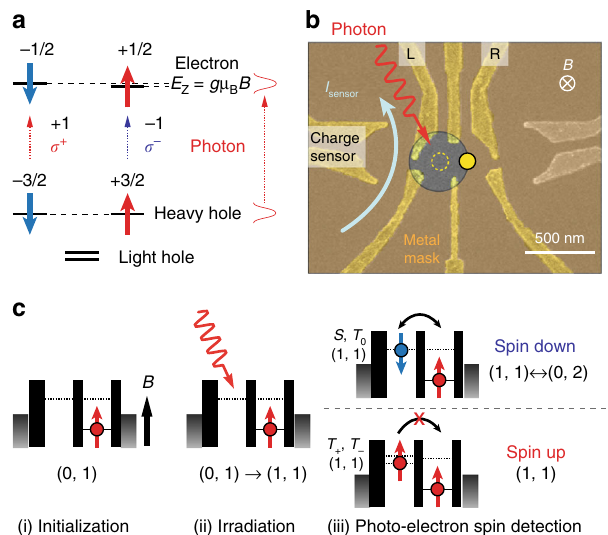
Fig. 1 Photo-electron spin detection scheme. a Angular momentum conservation in the heavy-hole band excitation. The numbers are the angular momenta of the respective particles in units of ħ . b Scanning- electron-micrograph picture of the double quantum dot (DQD) gate pattern nominally identical to the measured sample. We mainly use the charge sensor quantum dot (QD) formed on the left. The actual sample has a metal mask placed on an insulator fi lm. Photons are irradiated onto the left dot through an aperture in the metal mask in transparent yellow. c Sequence of the single photo-electron spin measurement: (i) Initialization to (0, ↑ ) by waiting long enough at the (0,1) charge state, (ii) exciting an electron – hole pair. We post-select the events where a single electron is captured in the left QD, and (iii) single photo-electron-spin measurement. the (1,1)-(0,2) transition. The DQD is initialized back to (0, ↑ ) by waiting